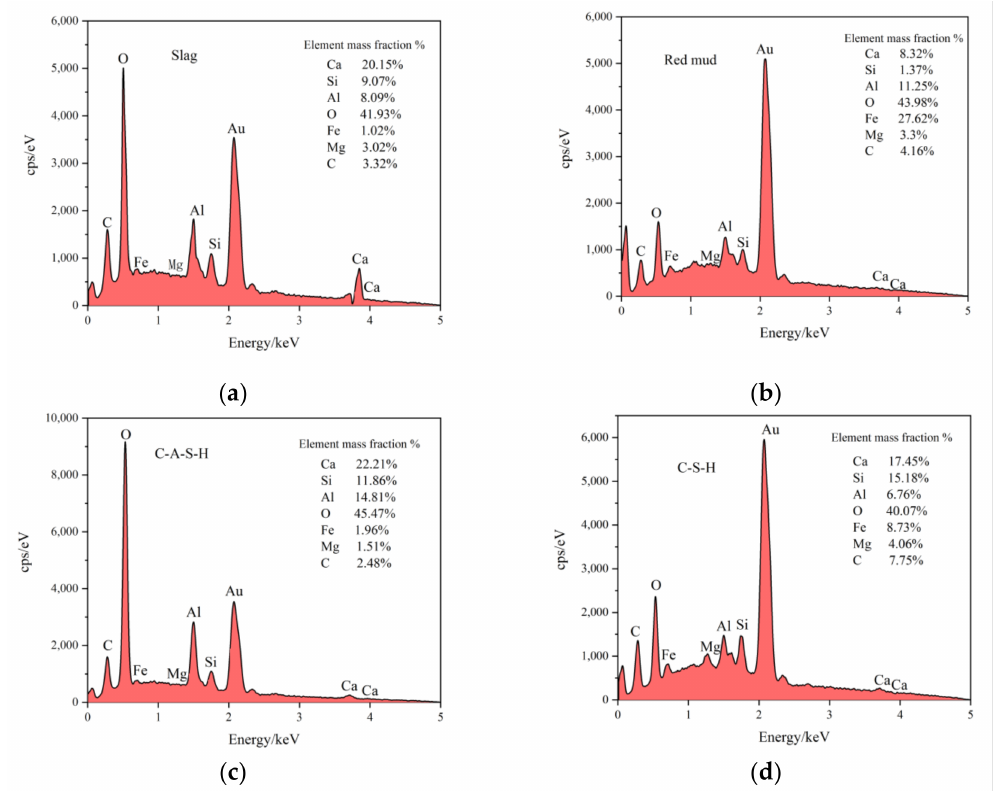
Figure 13. EDS analysis results: ( a ) point A, ( b ) point B, ( c ) point C, and ( d ) point